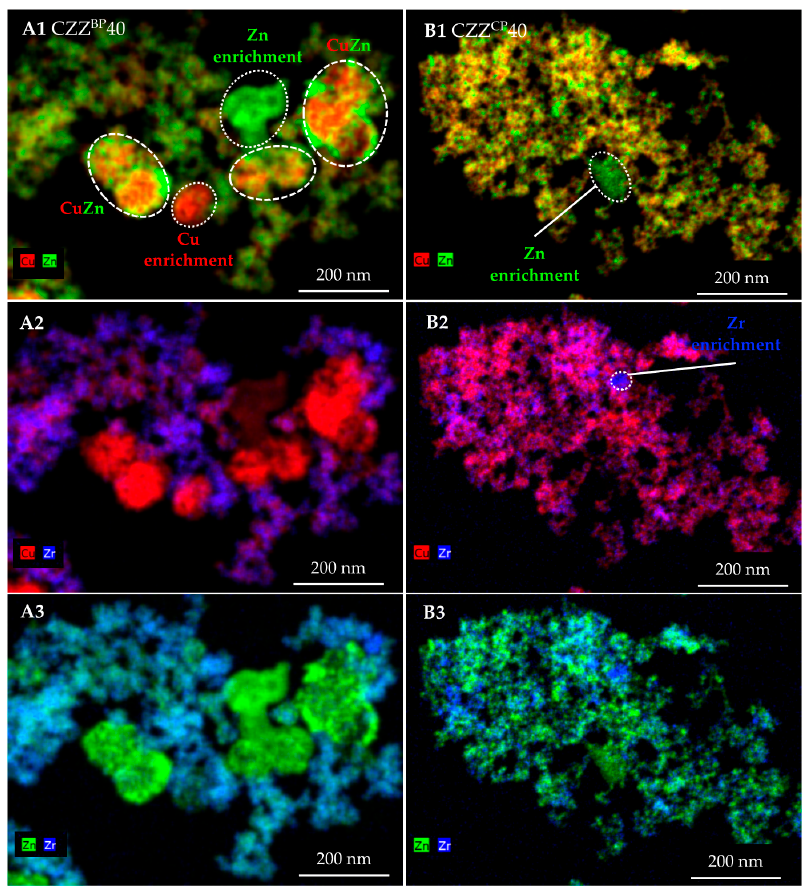
Figure 4. EDXS maps of ( A ) CZZ BP 40, and ( B ) CZZ CP 40. The images show the qualitative distribution of ( A1 , B1 ) Cu + Zn, ( A2 , B2 ) Cu + Zr, and ( A3 , B3 ) Zn + Zr in the pre-catalysts in a section of 630 × 860 nm.